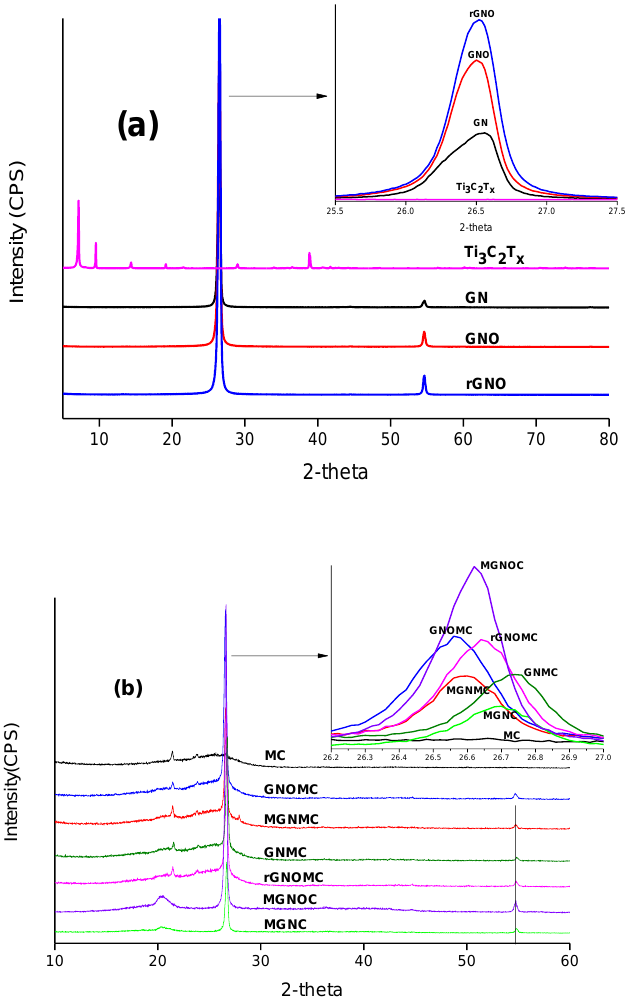
Figure 3. XRD of ( a ) rGNO, GNO, GN, MXene and ( b ) composites.